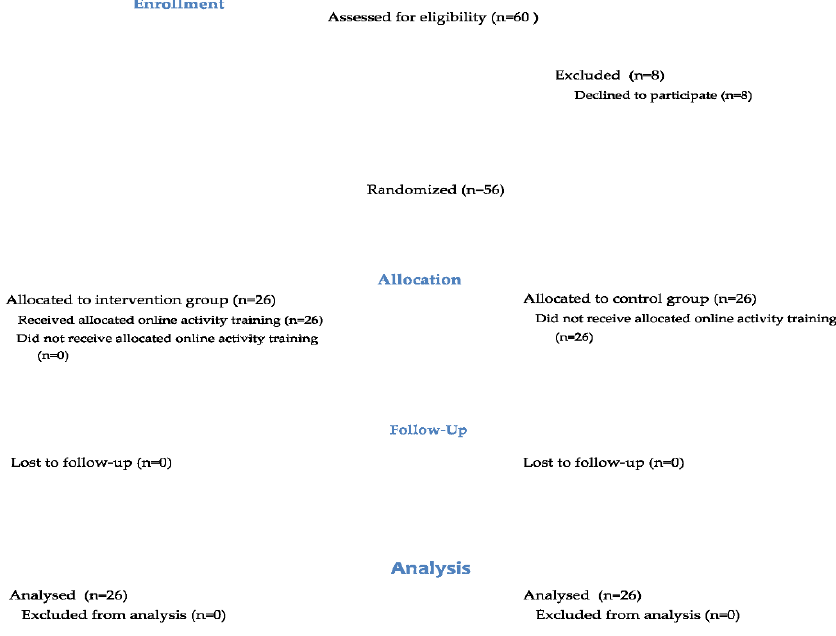
Figure 1. CONSORT flow diagram: the flow of children during each trial phase. Table 2. One week example of group activities performed via Zoom